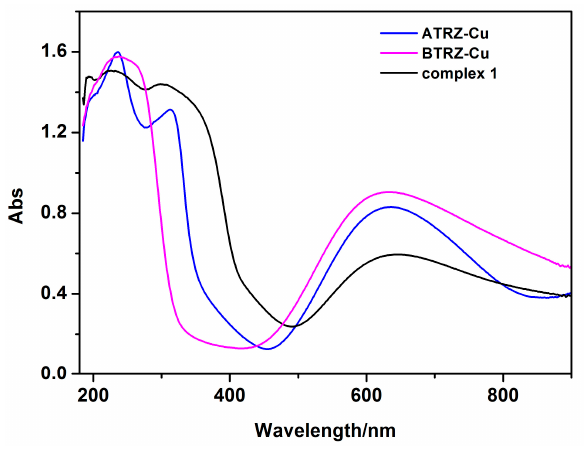
Figure 3. Ultraviolet absorption spectra of complex 1 , ATRZ-Cu and BTRZ-Cu.